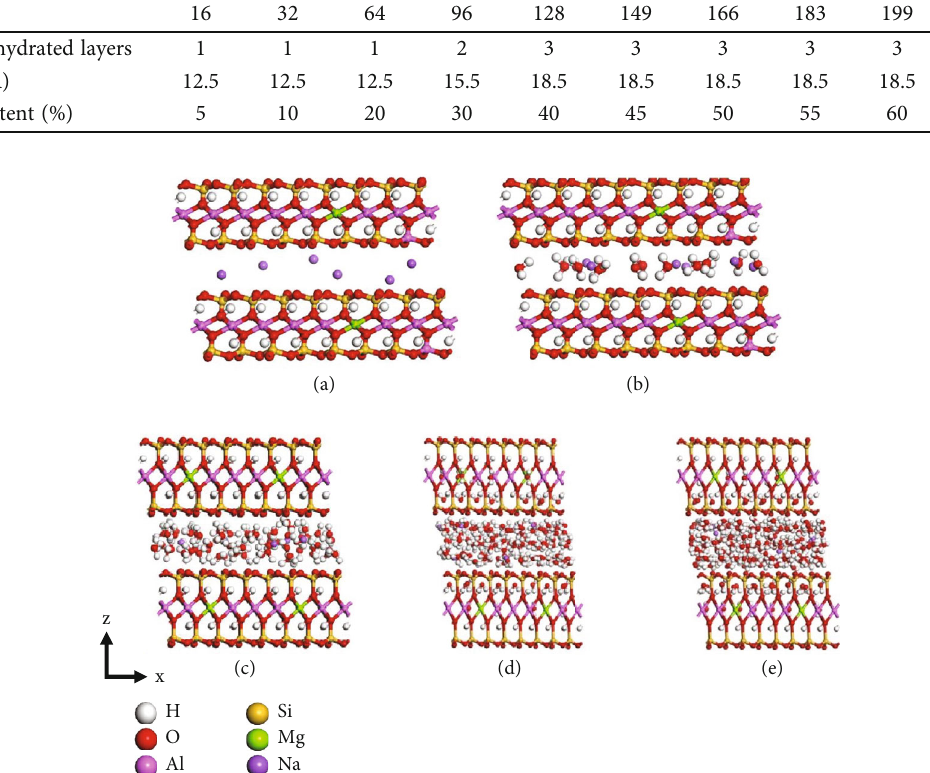
Figure 1: Na-Mnt in di ff erent hydrated layers: (a) dry state, (b) 1-layer hydrated, (c) 2-layer hydrated, (d) 3-layer hydrated, and (e) 4-layer hydrated. Table 2: CEC of Na-Mnt.